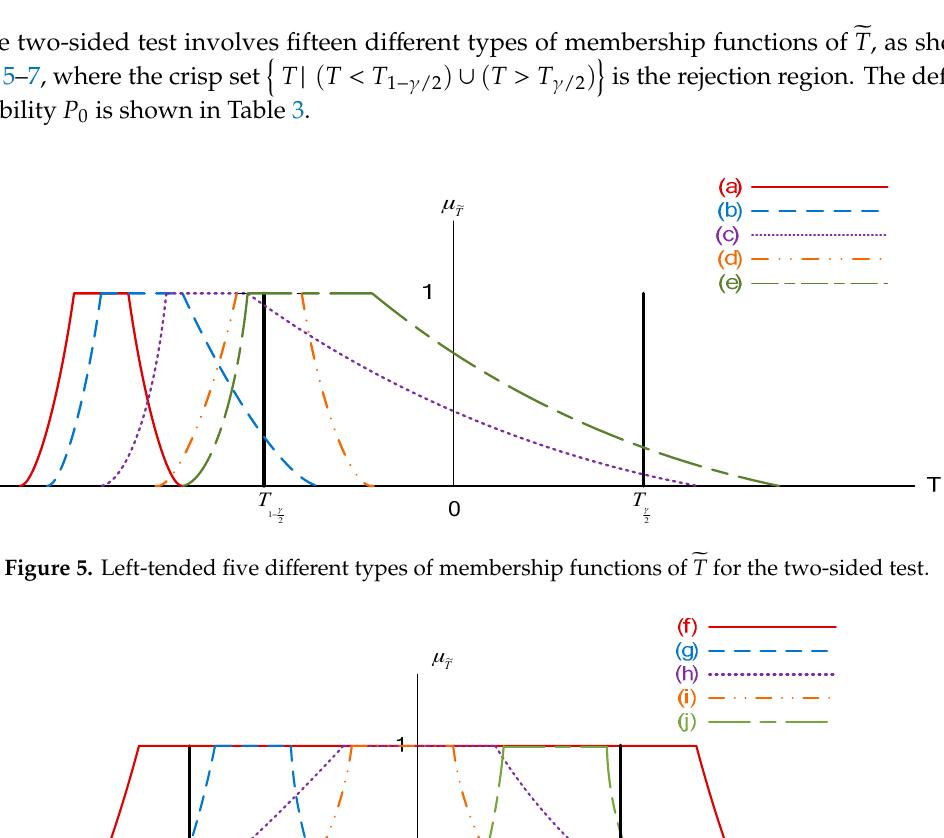
Figure 6. Centralized five different types of membership functions of T for the two-sided test.